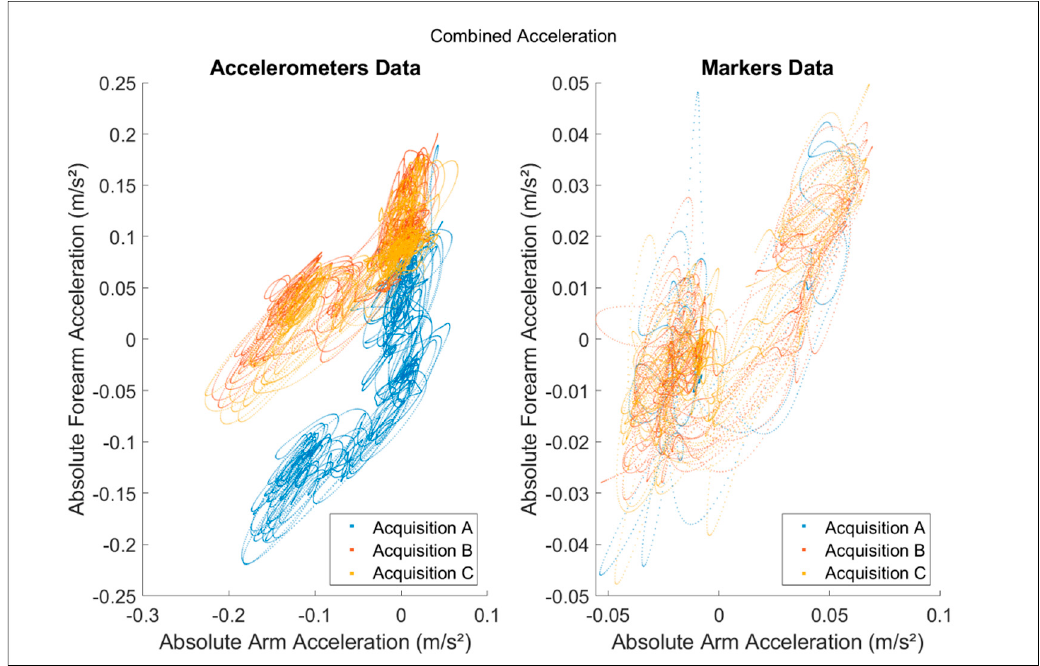
Figure 8. From the left, a acc signals of arm and forearm with respect to time. Colors refer to the acquisitions: blue for Acquisition A, red for B, and yellow for C.